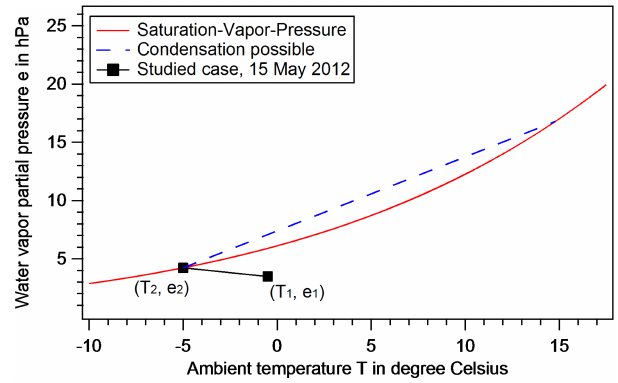
Figure 10. Isobaric mixing diagram for parcels of cloudy and a dry air: the red line denotes the water vapor partial pressure for sat- uration, and the blue dashed line exemplifies a mixing line along which the cloudy air parcel ( T 2 , e 2 ) could have been mixed with another parcel such that supersaturation results. However, for the studied case from Flight 11 on 15 May 2012 (as represented by the short, straight, black line) no conditions for supersaturation and for aerosol particle activation arise. (The thermodynamic param- eters of T 1 = − 0 . 5 ◦ C, RH 1 = 59%, e 1 = 3 . 5hPa for dry air and T 2 = − 5 ◦ C, RH 2 = 100%, e 2 = 4 . 2hPa inside the cloud are based on the